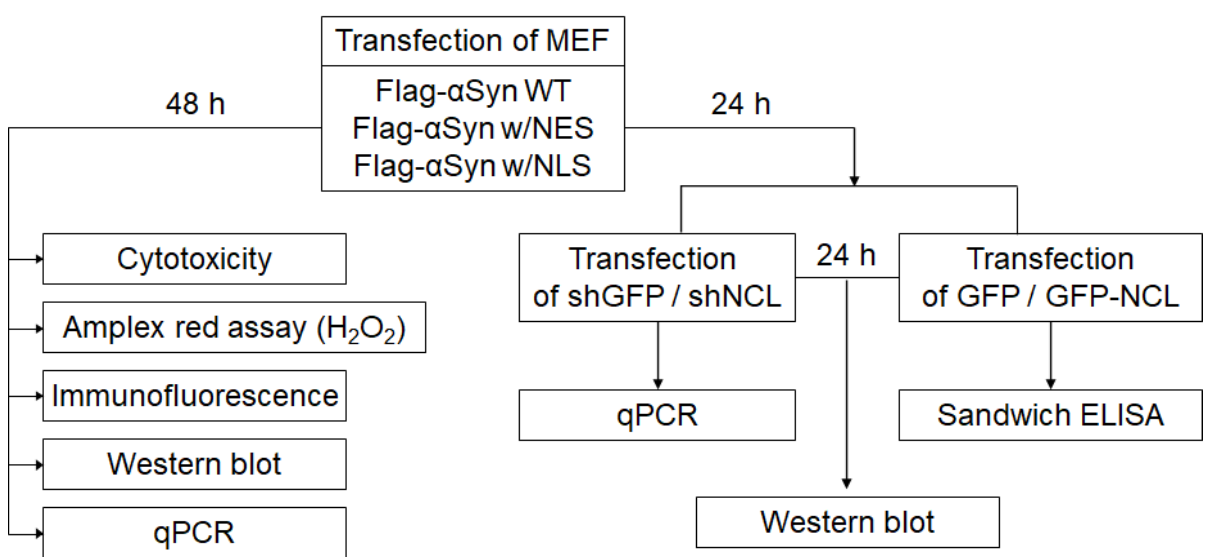
Figure 1. The methodological scheme. The experimental approaches that we applied in this study can be illustrated as the above